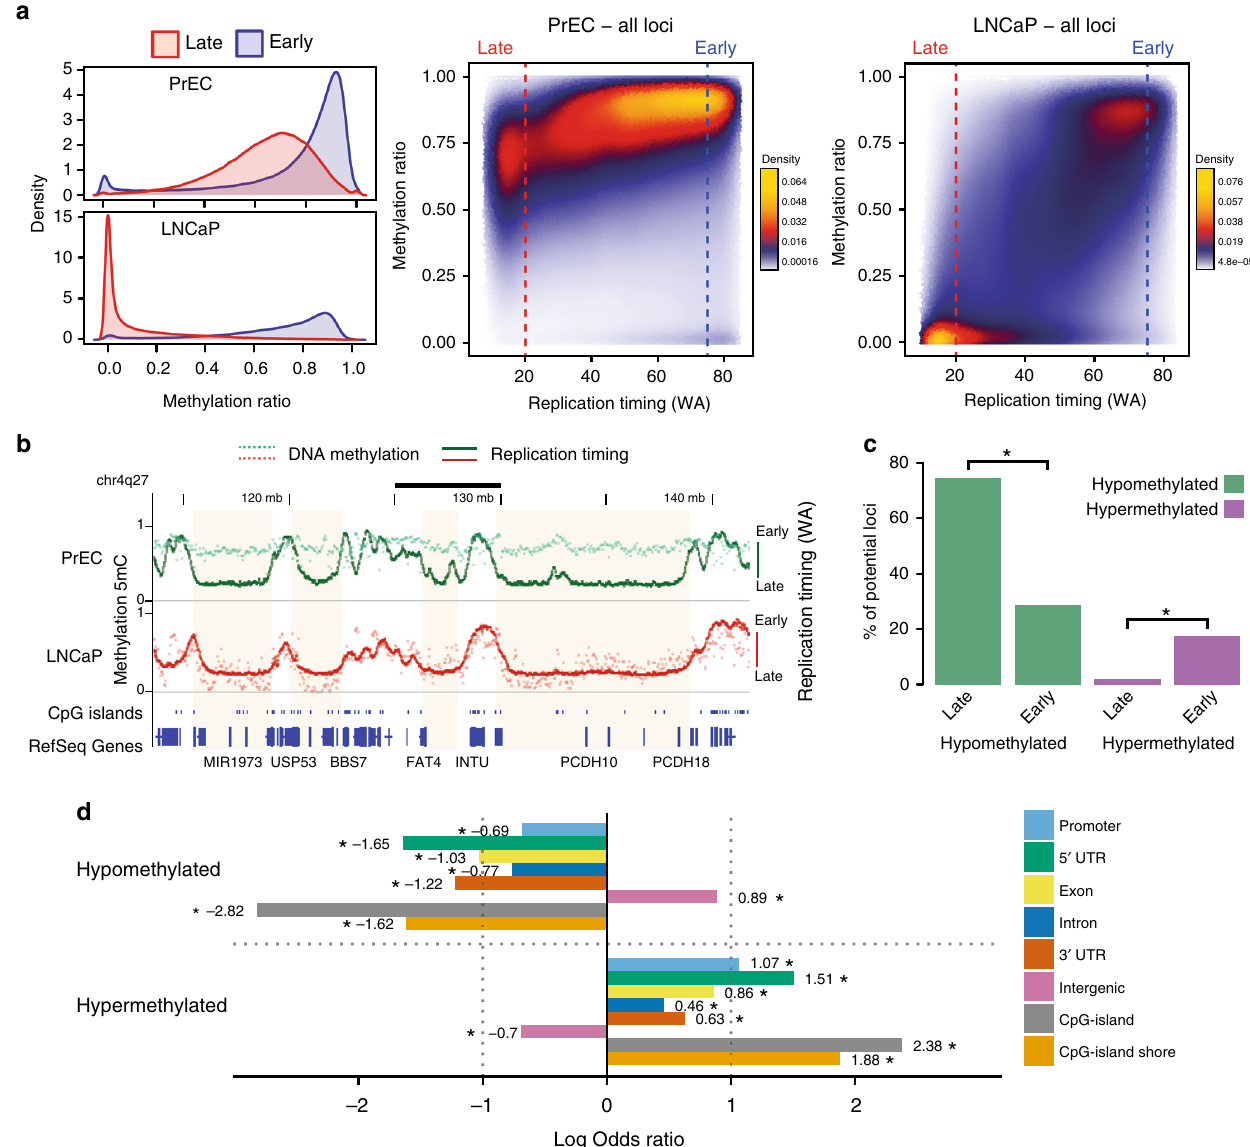
Fig. 2 Replication timing correlates with DNA methylation in cancer. a DNA methylation (WGBS) density distributions for early (blue) and late (red) loci per cell line. Adjacent are scatterplots of DNA methylation in relation to replication timing (WA) for all measured 1 kb loci in PrEC and LNCaP. Blue dashed line indicates early (WA > 75) and red dashed line indicates late (WA < 20). b Representative examples of late-replicating regions common to both PrEC and LNCaP (shaded) that become hypomethylated in LNCaP. The correlation between DNA methylation and replication timing values increases from PrEC (Spearman ’ s 0.3073, p < 2.2e − 16) to LNCaP (Spearman ’ s 0.4985, p < 2.2e − 16). Scale bar represents 5 Mb. c Percentage ( y -axis) of PrEC early and late regions (1 kb loci) that are hypermethylated (LNCaP-PrEC, Δ WGBS > 0.2) and hypomethylated (LNCaP-PrEC, Δ WGBS < − 0.2). Asterisks indicate signi fi cantly different percentages between early and late (test of equal proportions, p < 2.2e − 16). d Associations between genomic elements and hypo- and hypermethylated 1 kb loci. Association is above zero, and disassociation is below zero. Asterisks indicate signi fi cant associations (FDR < 0.05, Fisher ’